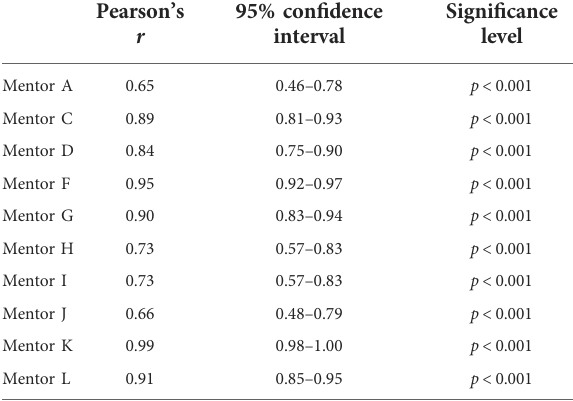
TABLE 1 Mentee/mentor assessment correlation coef fi cients for individual mentors.